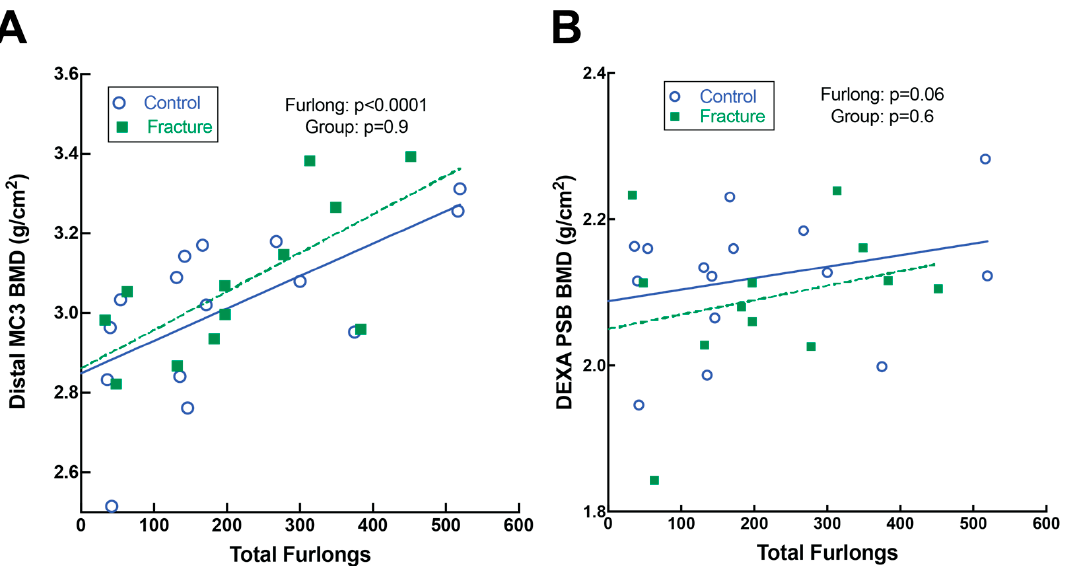
Figure 5. Dual-energy X-ray absorptiometry (DXA) analysis of the distal metacarpus (MC3) and PSBs. ( A ) Distal MC3 bone mineral density (BMD) did not differ between fracture and control groups but was greater in horses with more total furlongs. ( B ) Proximal sesamoid bone (PSB) BMD did not differ between fracture and control groups nor in horses with more total furlongs, though there was a non-significant trend for greater BMD with more total furlongs.